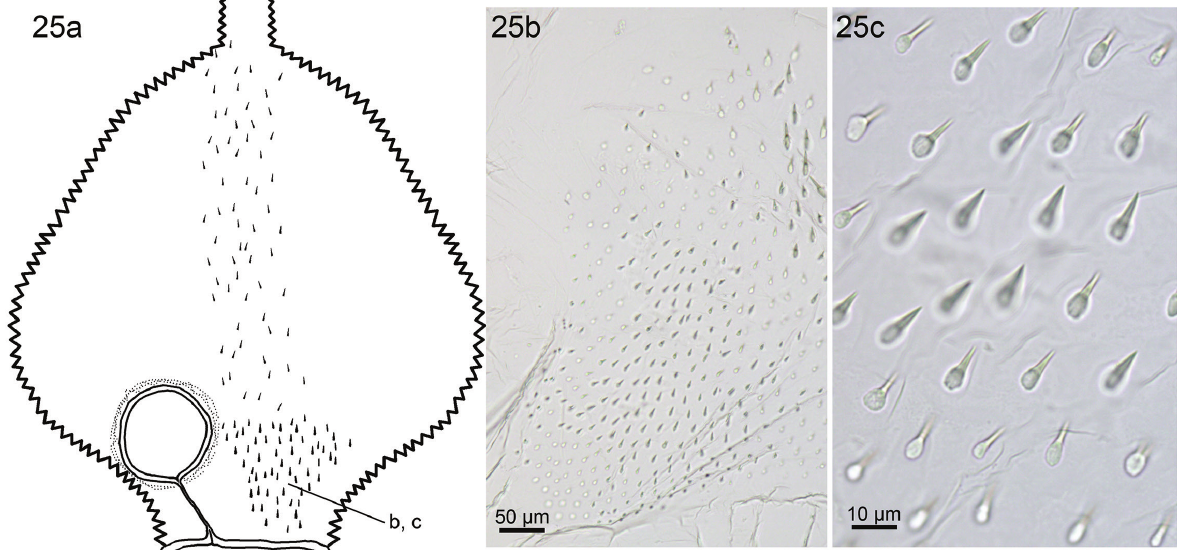
Figure 25. Uncitermes teevani . (a) Schematic drawing of P1 showing arrangement of spines. (b, c) Photomicrographs: (b) General view of the robust spines covering the proximal portion; (c) Detail of robust spines.